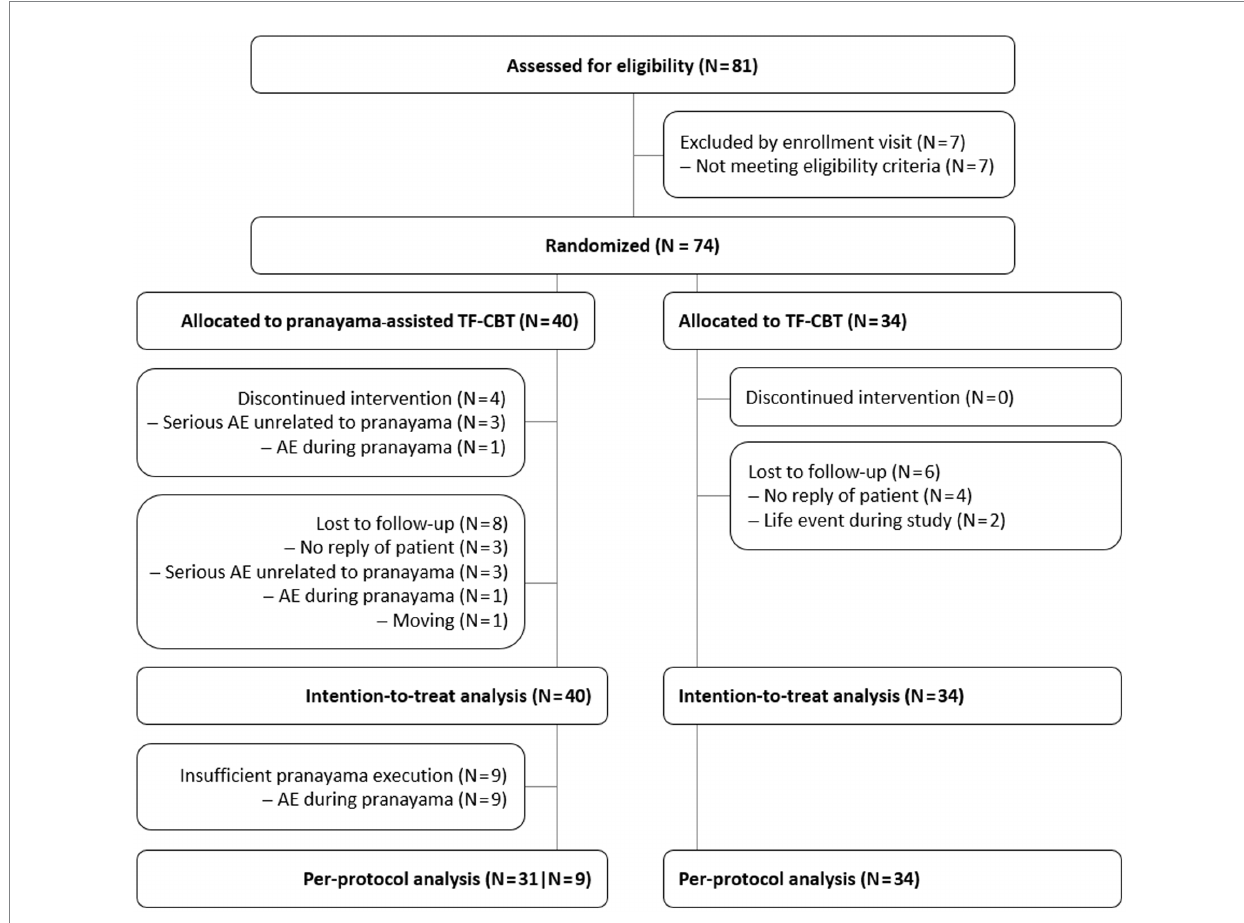
FIGURE 1 CONSORT patient flow. N = Number of patients, TF-CBT = Trauma-focused cognitive behavioral